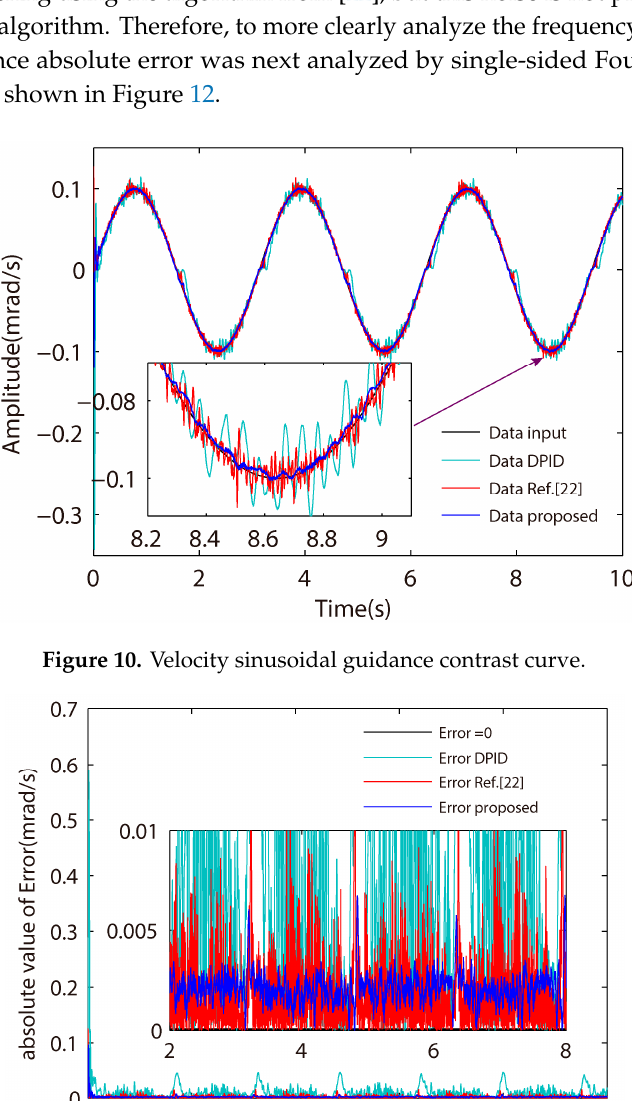
Figure 12. Frequency domain analysis of guidance absolute error curve. According to the results presented in Figure 12, nonlinear disturbance can be effectively suppressed by both the proposed and the algorithm described in [22]. The PID linear controller exhibits limited ability to suppress medium and low frequency noise. There is obvious high frequency noise in the error curve caused by the sliding mode chattering of the Ref. [22] chatter-